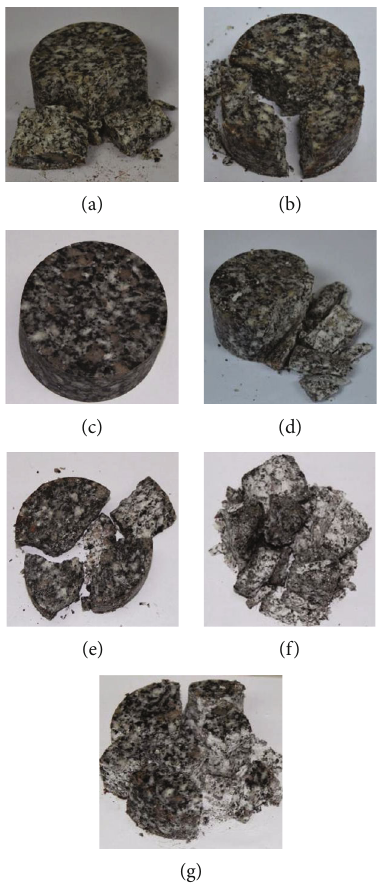
Figure 6: Impact failure pattern of granite: (a) 25 ° C; (b) -5 ° C; (c) -10 ° C; (d) -15 ° C; (e) -20 ° C; (f) -30 ° C; (g) -40 ° C.